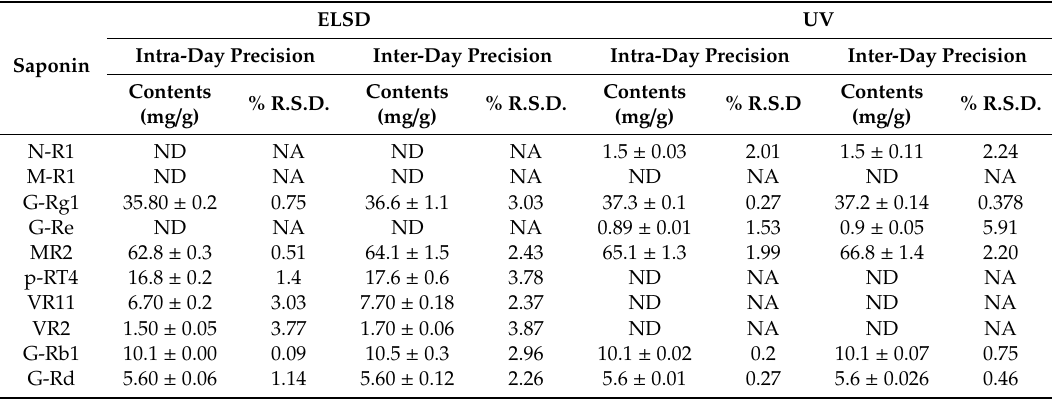
Table 2. Inter- and intra-day precision of the HPLC-ELSD-UV